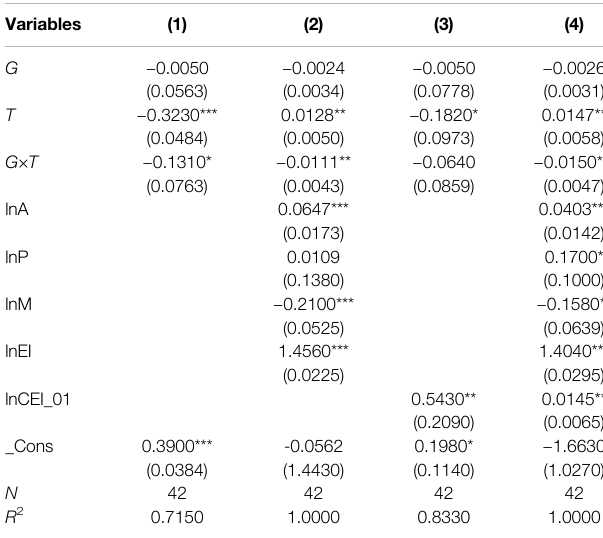
TABLE 4 | Descriptive statistics of